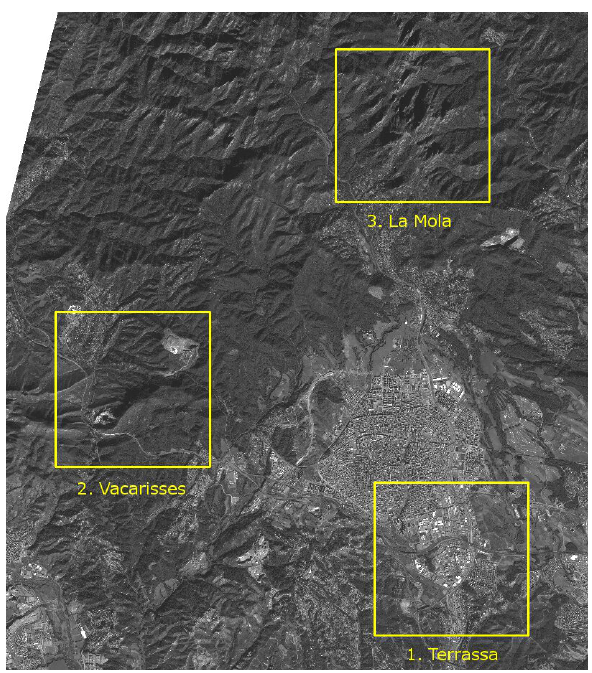
Figure 1. The three test areas near Barcelona,